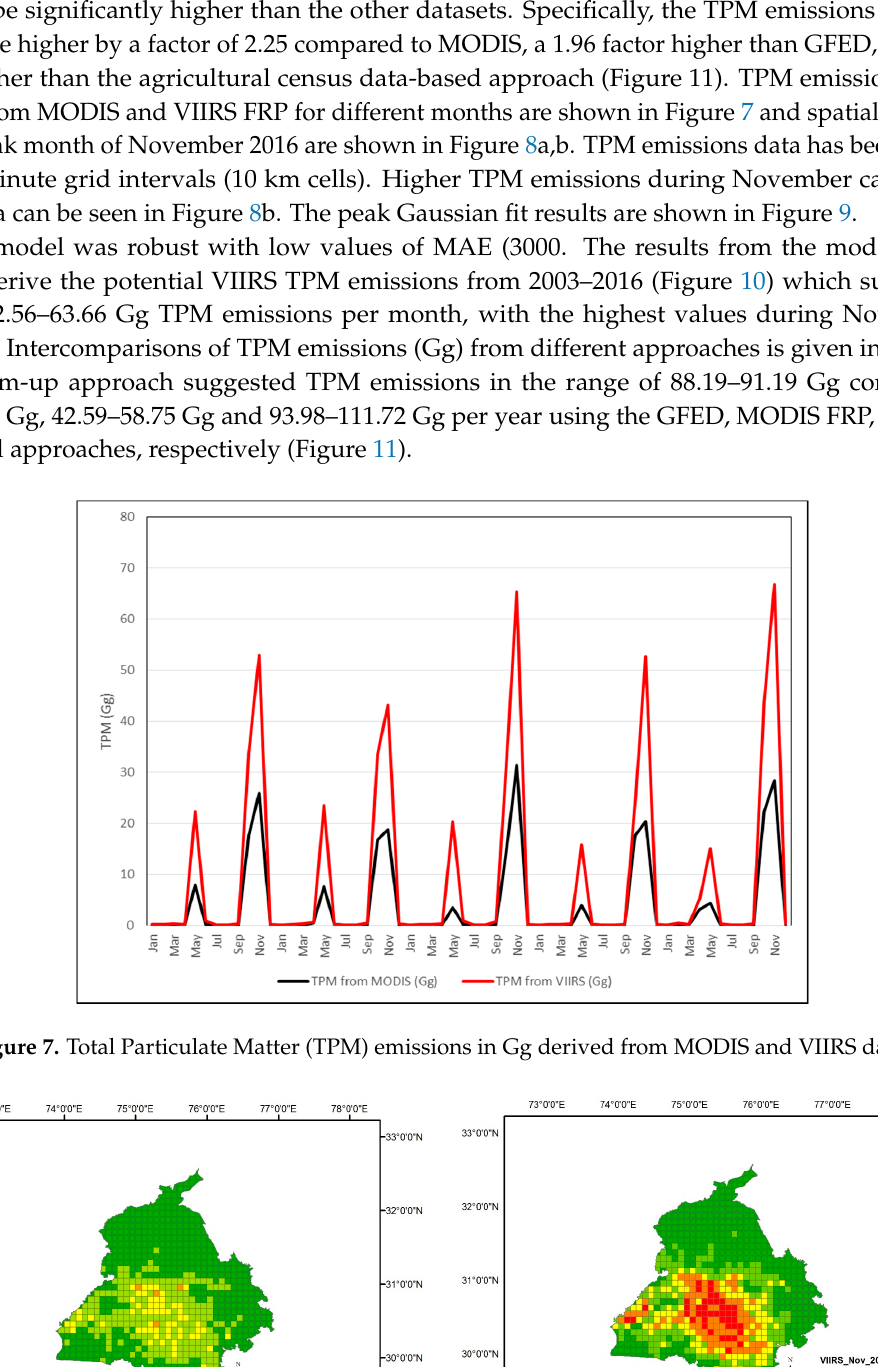
Figure 8. TPM emissions (in Gg) from MODIS ( a ) and VIIRS for the peak month of November ( b ), 2016. TPM emissions data has been gridded at 5 arc minute grid intervals (10 km cells). High FRP during November captured by VIIRS data can be seen in the Figure 8b.